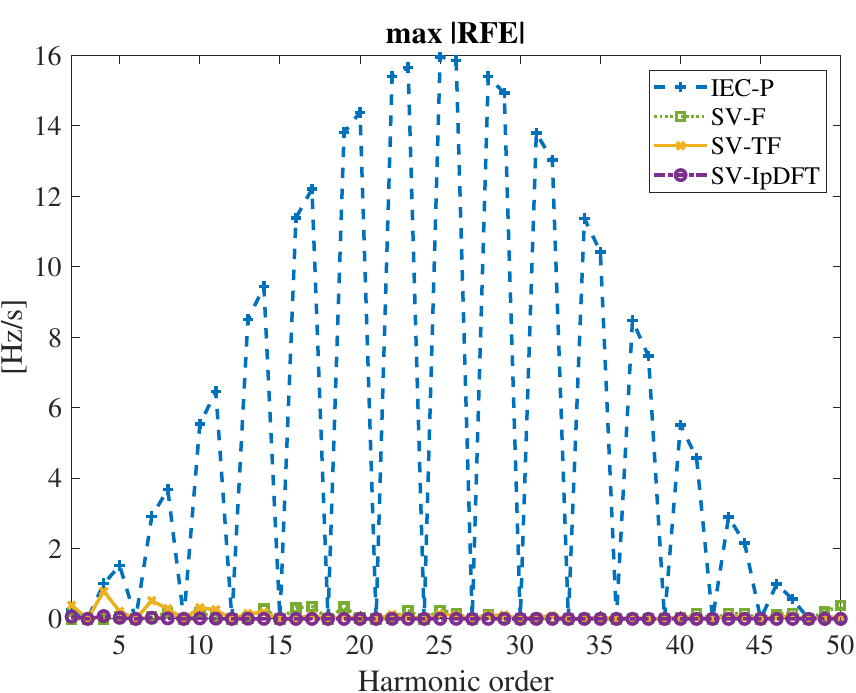
Figure 8. Maximum |RFE| in the presence of 1% harmonic disturbances, f =